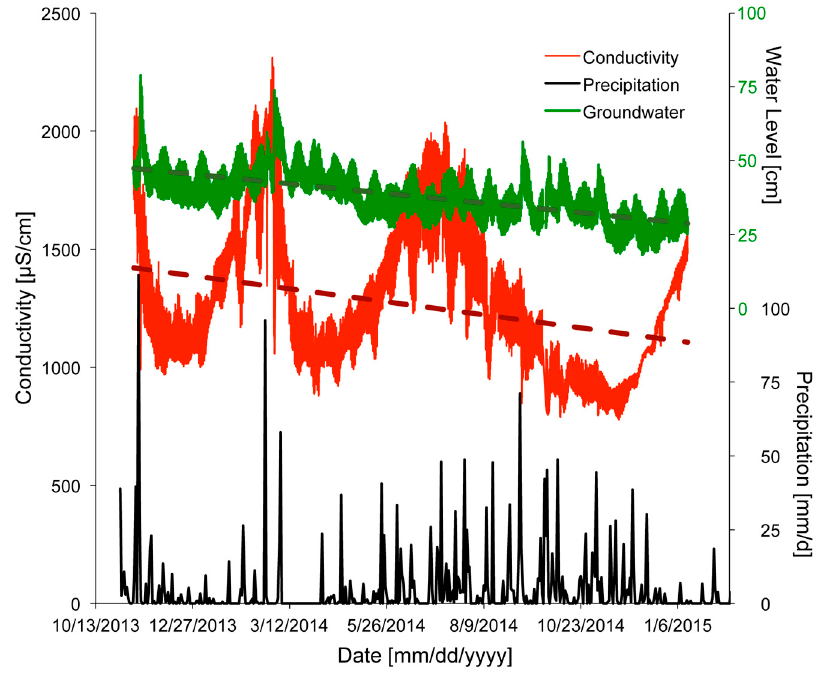
Figure 9. Time series plot showing variations in rainfall (black), groundwater level (green), and conductivity of water (red) in well R3 observed between November 2013 and February 2015. Linear fits to the data are denoted by dotted lines.